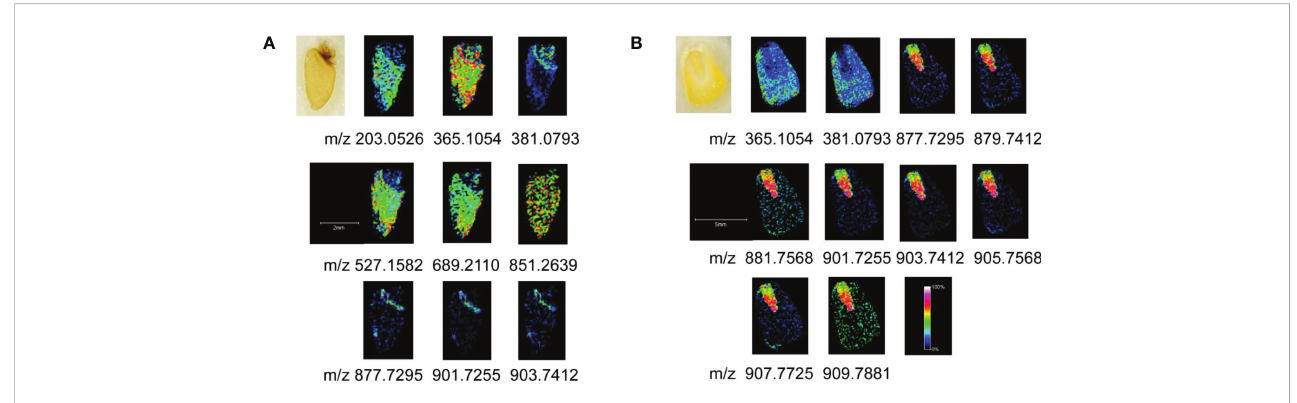
FIGURE 3 MALDI MSI of oligosaccharides and lipids. (A) Germinated wheat; (B) corn kernels.